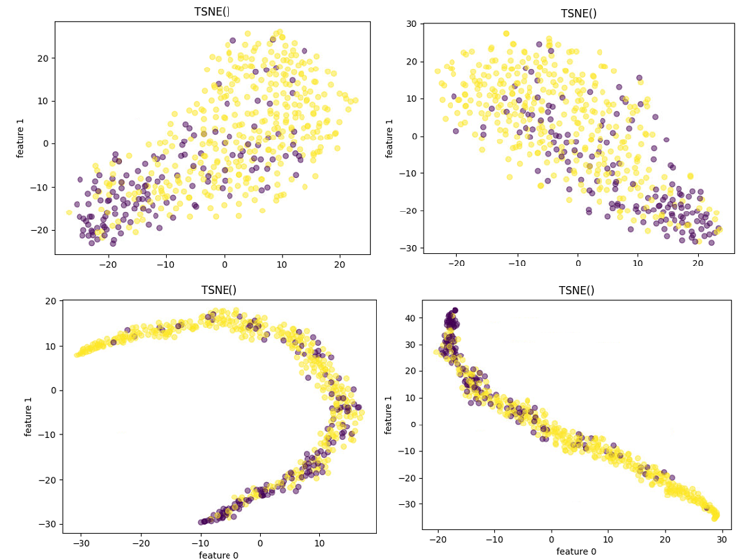
Figure 4. Visualization of the fc-features of ResNet18 ( top left ), ResNet34 ( top right ), ResNet50 ( bottom left ) and ResNet101 ( bottom right ) on the test set by TSNE. Purple dots represent low- quality images and yellow dots represent high-quality